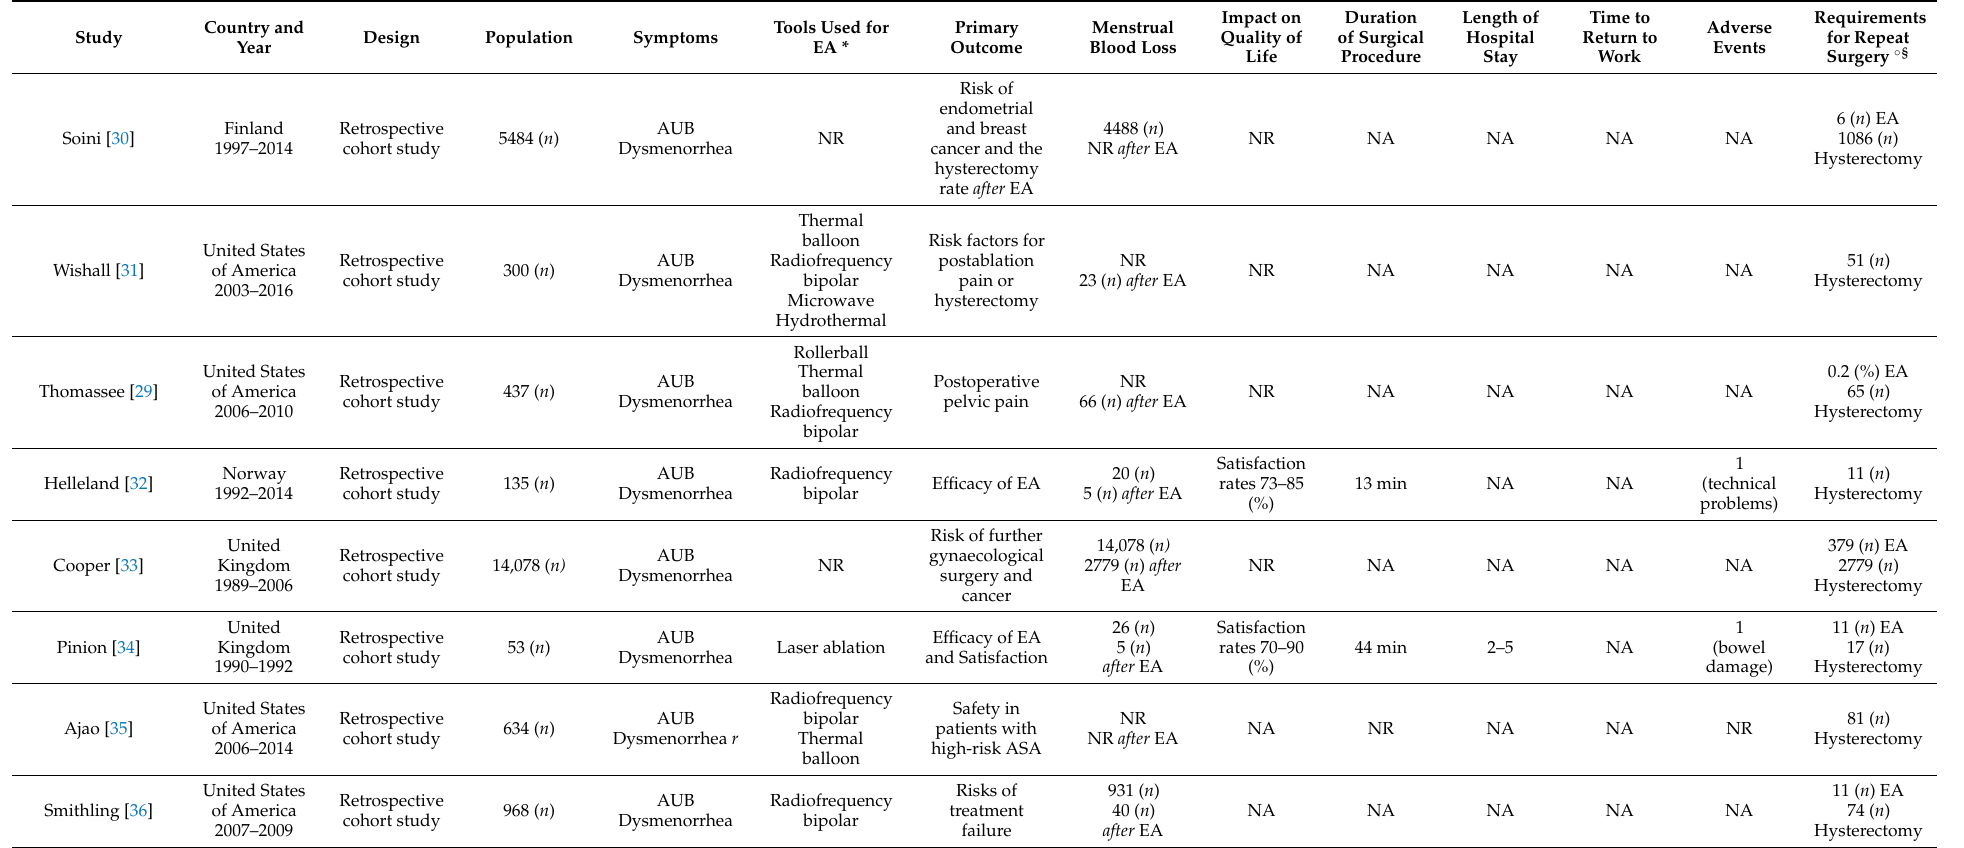
Table 1. Characteristics of the included